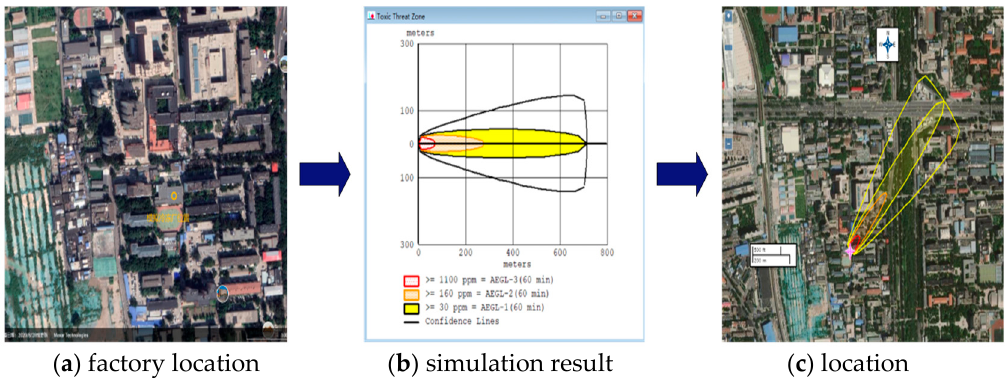
Figure 7. Bayesian network diagram of liquid ammonia leakage.